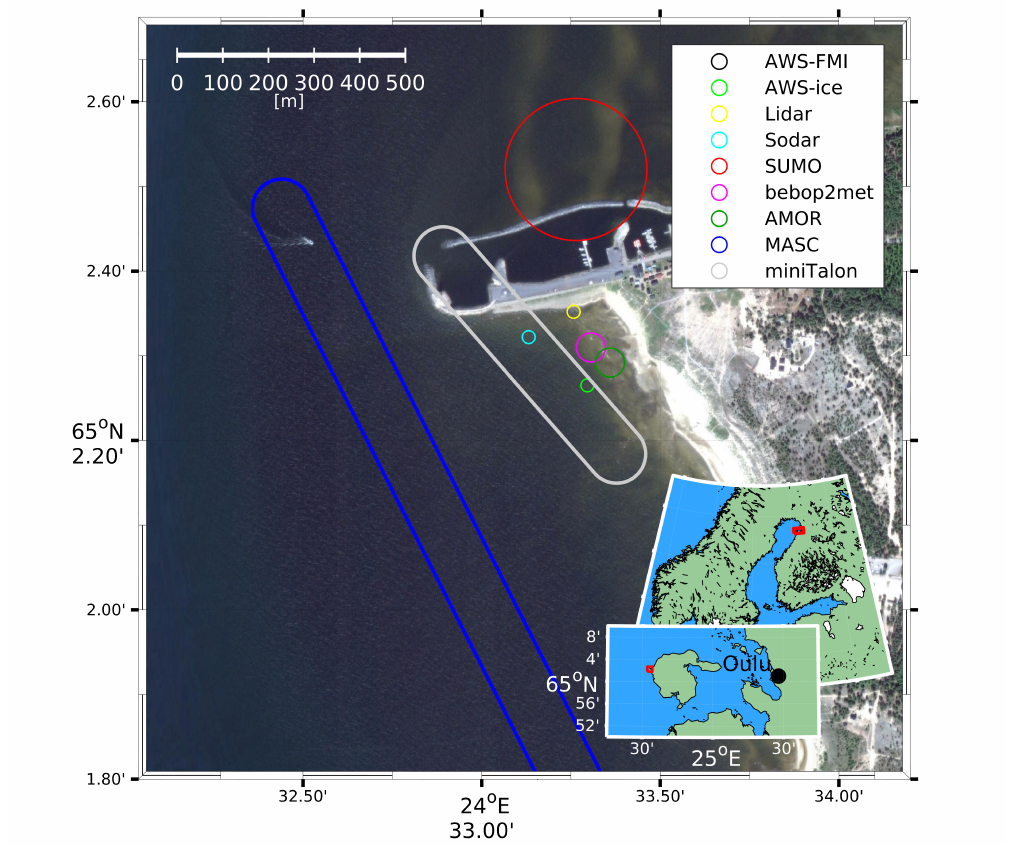
Figure 1. Overview maps showing the Hailuoto-I campaign site, the location of the ground-based instrumentation and typical locations and paths of the Unmanned Aerial Vehicle (UAV)